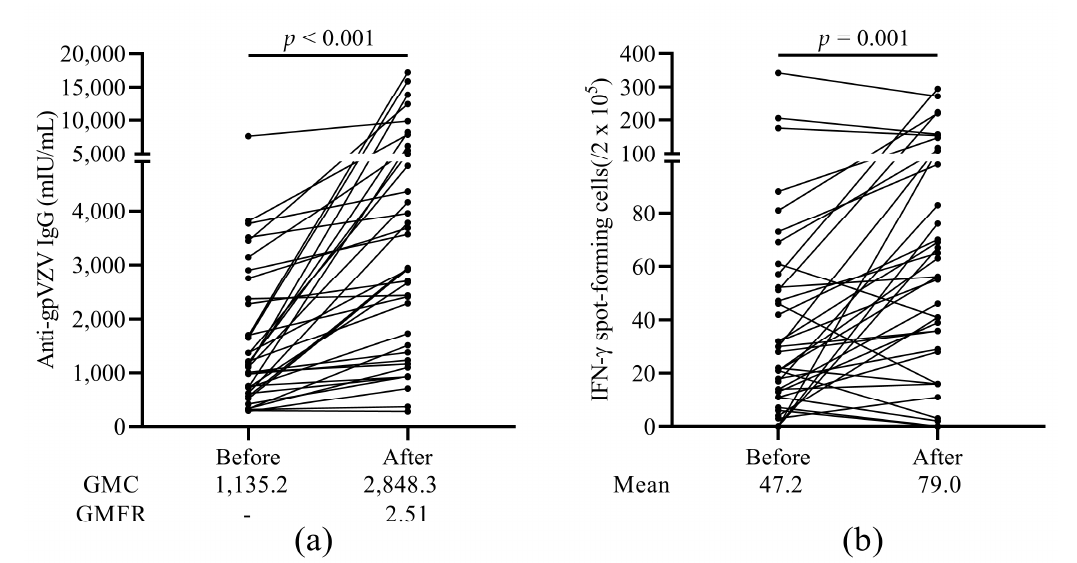
Figure 2. Humoral and cellular immunogenicity of the HZ vaccine. ( a ) Levels of anti-glycoprotein (gp) VZV IgG antibody. GMC and GMFR are shown under the figure. ( b ) The number of VZV stimulated IFN-γ spot-forming cells (SFCs) before and after vaccination. HZ, herpes zoster; gp, glycoprotein; VZV, varicella zoster virus; GMC, geometric mean concentrations; GMFR, geometric mean fold rise.